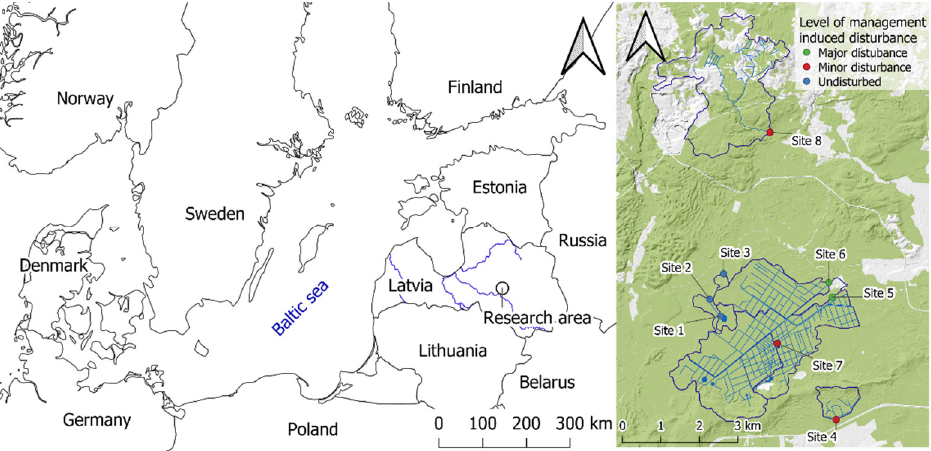
Figure 1. The research area, located in the experimental forests of the Kalsnava Forest district, eastern Latvia. Maps were made in QGIS Desktop (v3.16.3). Table 1. Characterization of the sampling sites.